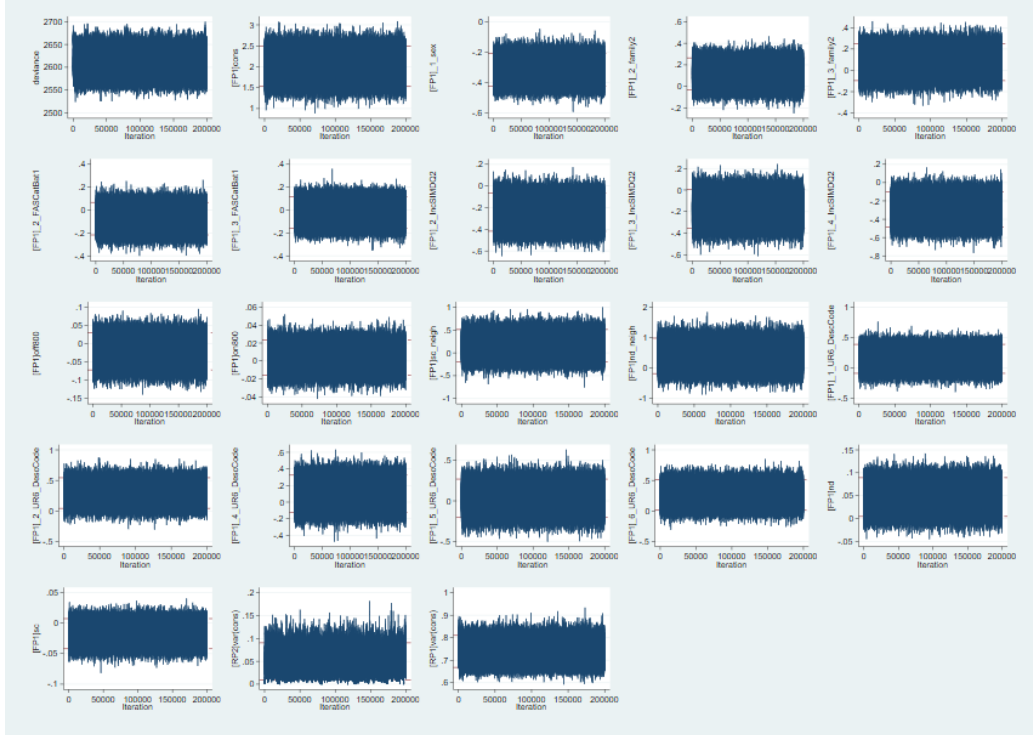
Figure A1. Trajectory plots for model 3, outcome is coping